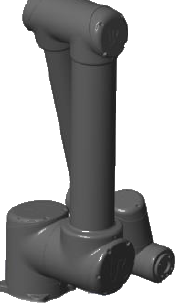
Figure 12. Stowed position for the collaborative robot UR10.